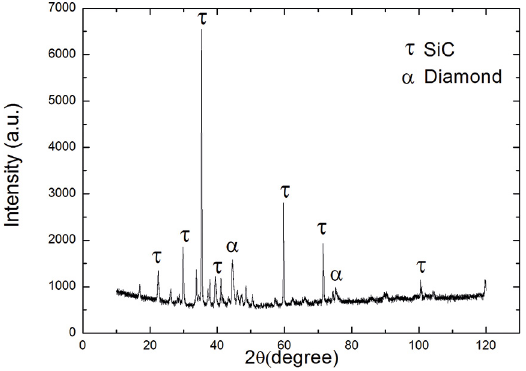
Figure 8. X-ray diffractogram of the diamond film on